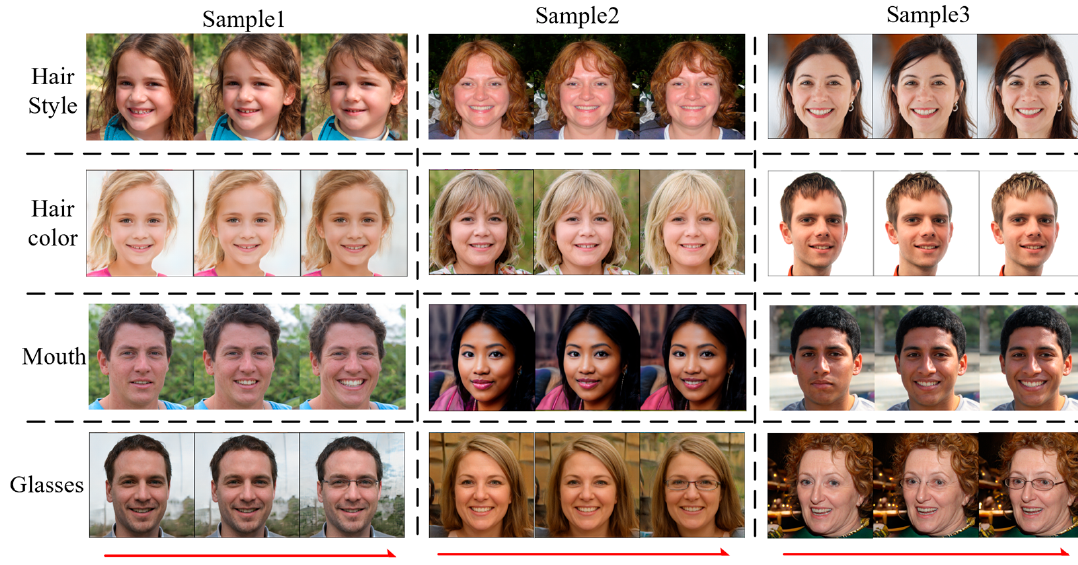
Figure 14. Local Jacobi disentangled method editing results for the FFHQ dataset.